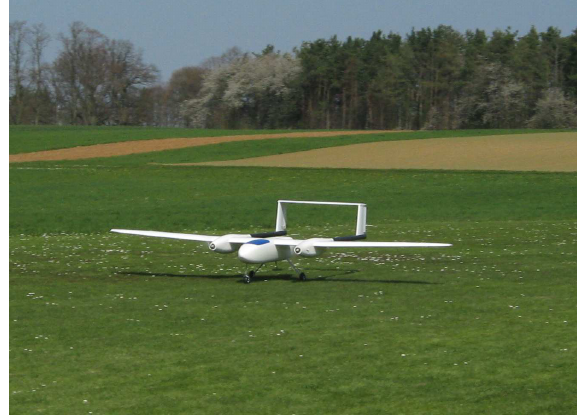
Figure 1: UAS “Stuttgarter Adler” before take-off